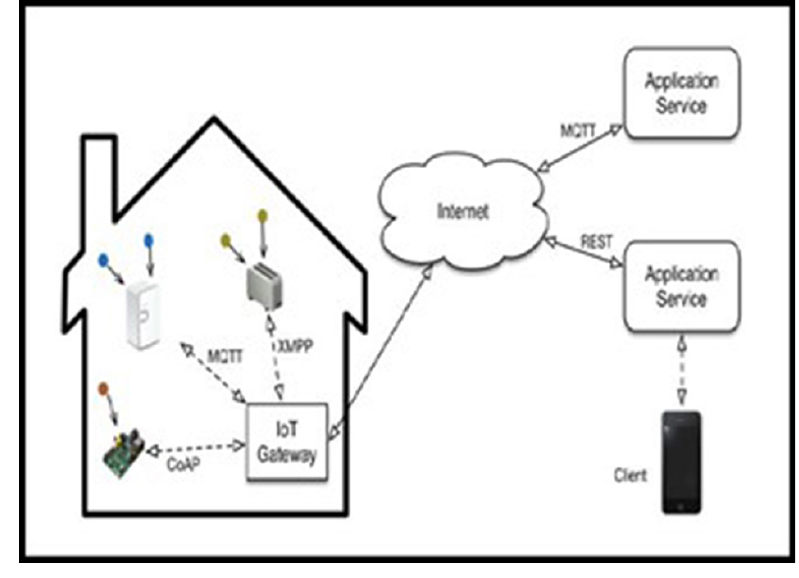
Fig. 1. The Internet of Things protocols